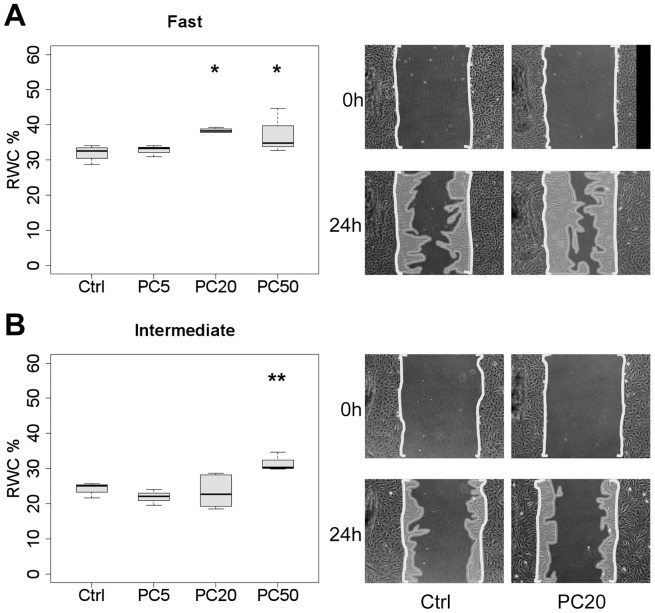
Small effect of PDGF-CC on wound closure by fibroblasts in vitro.Boxplots represent the RWC in scratch wound assays at 24 h (*p<0.05, **p<0.01) of “fast” (A) and “intermediate” (B) CLP strains in 0.3% FCS/DMEM in the absence (control; Ctrl) or the presence of PDGF-CC diluted at either 5 ng/ml (PC5), 20 ng/ml (PC20) or 50 ng/ml (PC50). Micrographs show representative examples at 0 and 24 h in the absence (Ctrl) or presence of PDGF-CC (P20; P50). Area of scale bar corresponds to 10% RWC or 0.32
mm2.